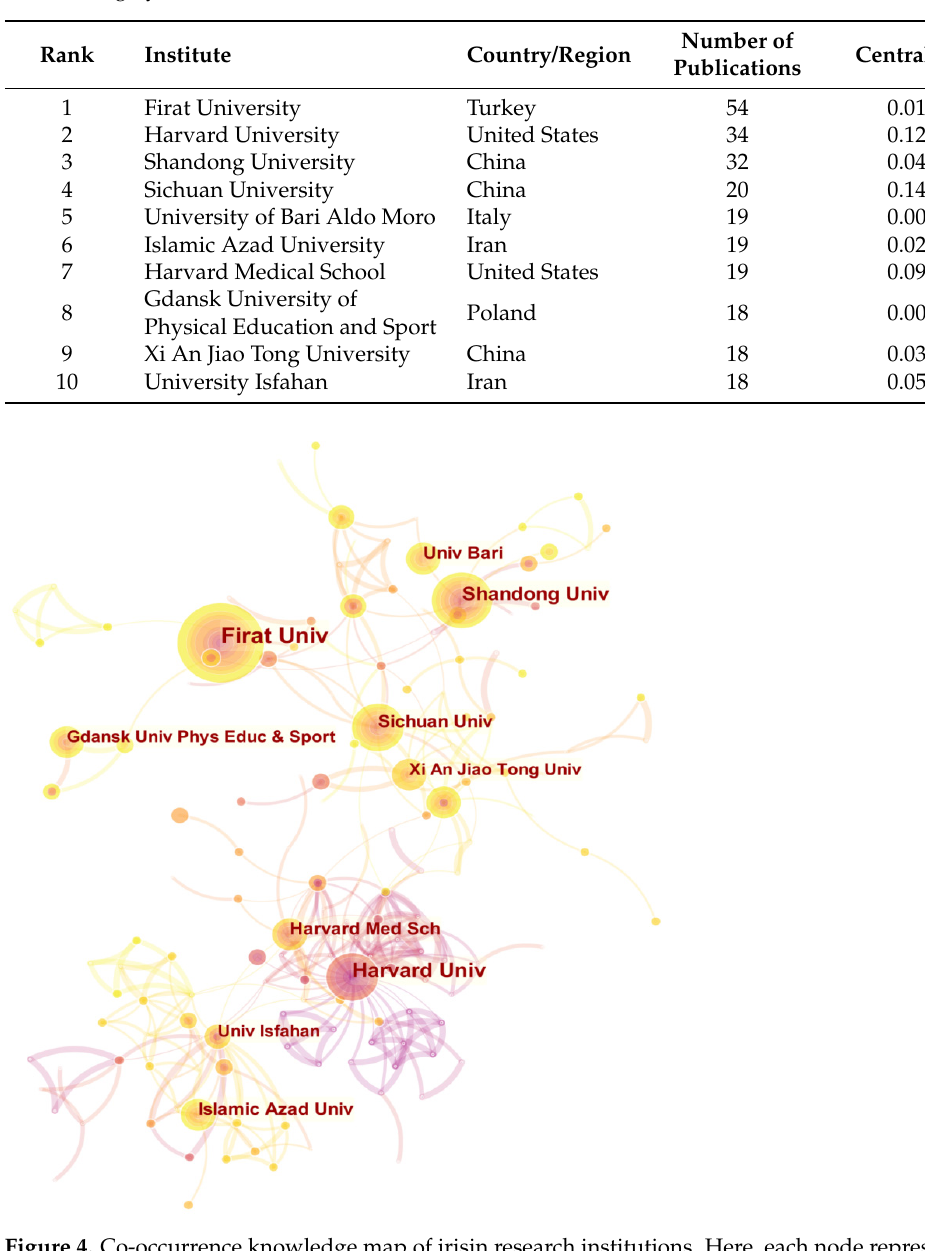
Table 2. High yield institution information of irisin research.